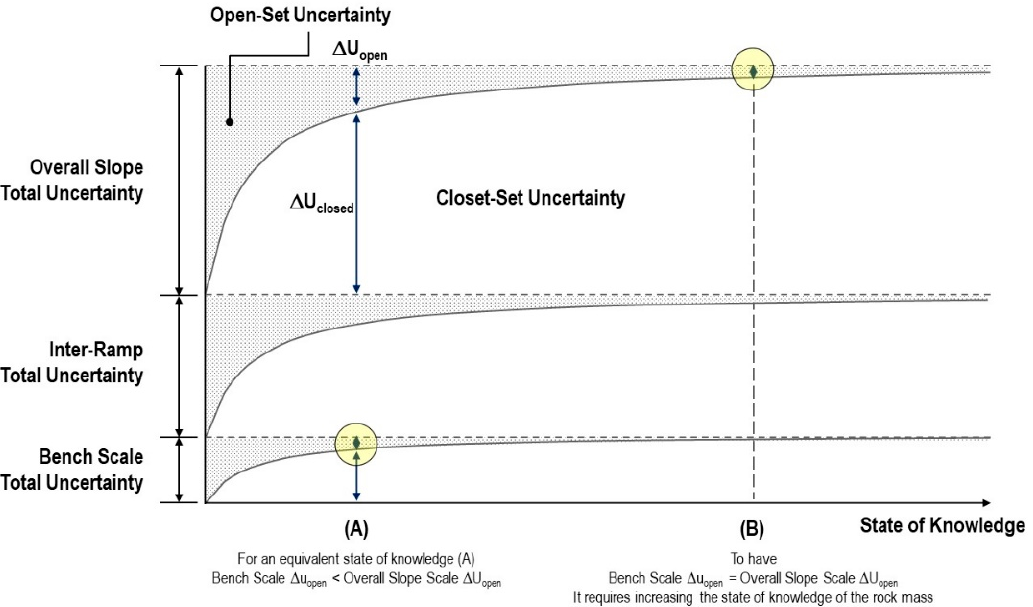
Figure 1. Definitions of open- and closed-set uncertainties, and how these change, for a given state of rock mass knowledge, depending on the scale of the problem being considered.